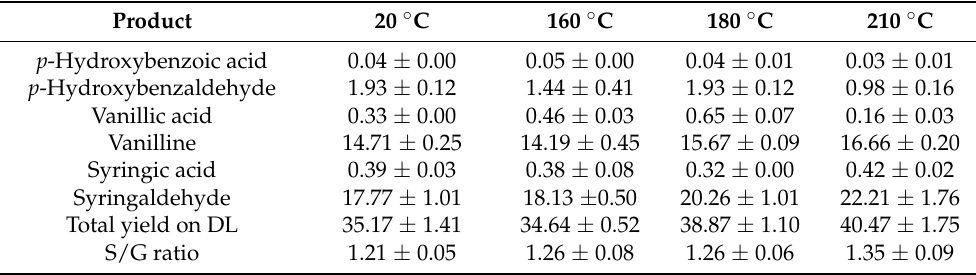
Table 2. Phenolic aldehydes and acids from nitrobenzene oxidation of meranti dioxane lignins (mean ± SD, %).